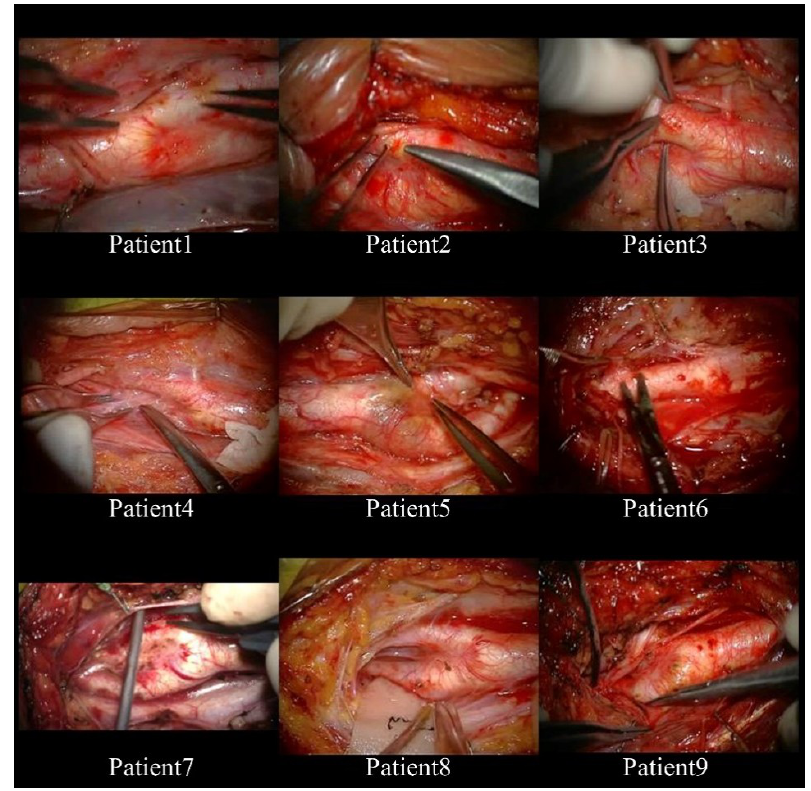
Figure 2. Representative images of the dataset for nine patients.